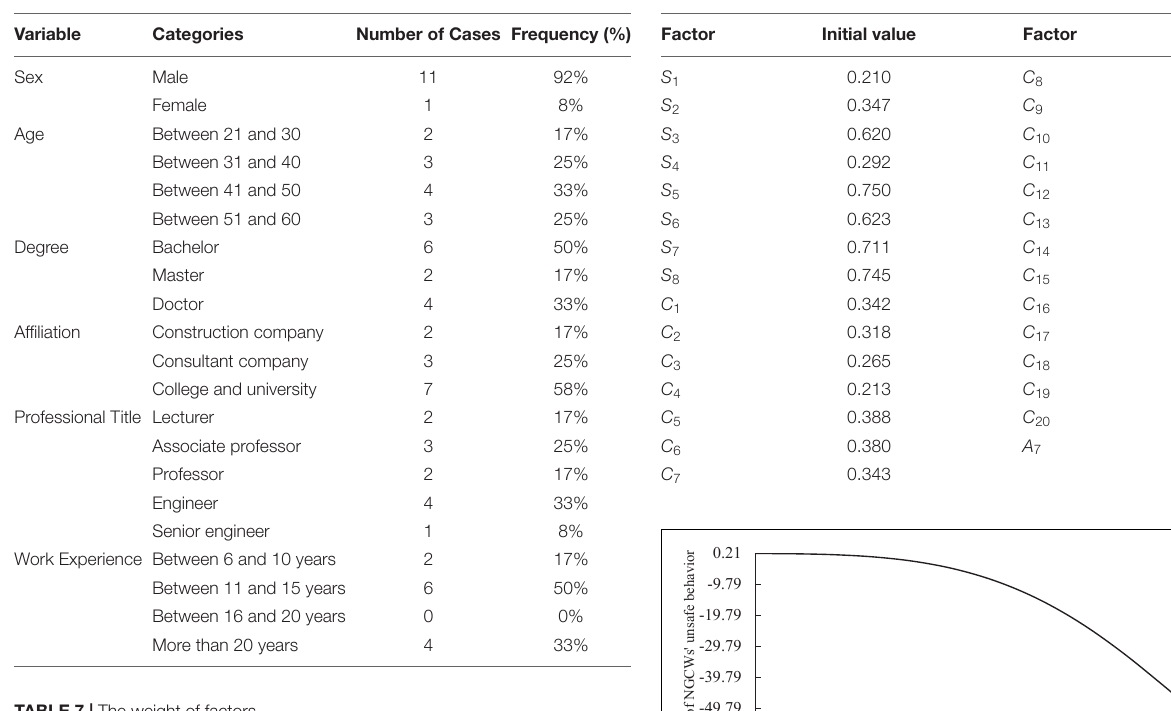
TABLE 6 | Basic information of experts ( N = 12).